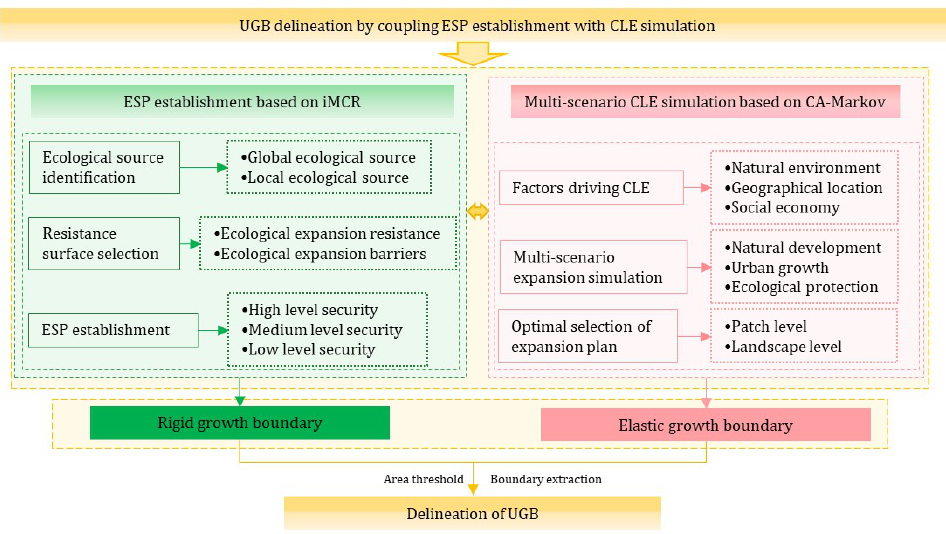
Figure 1. The research framework for delineation of the urban growth boundary (UGB) by cou- pling ecological security pattern (ESP) establishment with construction land expansion (CLE) sim- ulation. iMCR : improved minimum cumulative resistance model; CA–Markov: cellular automata–Markov model.